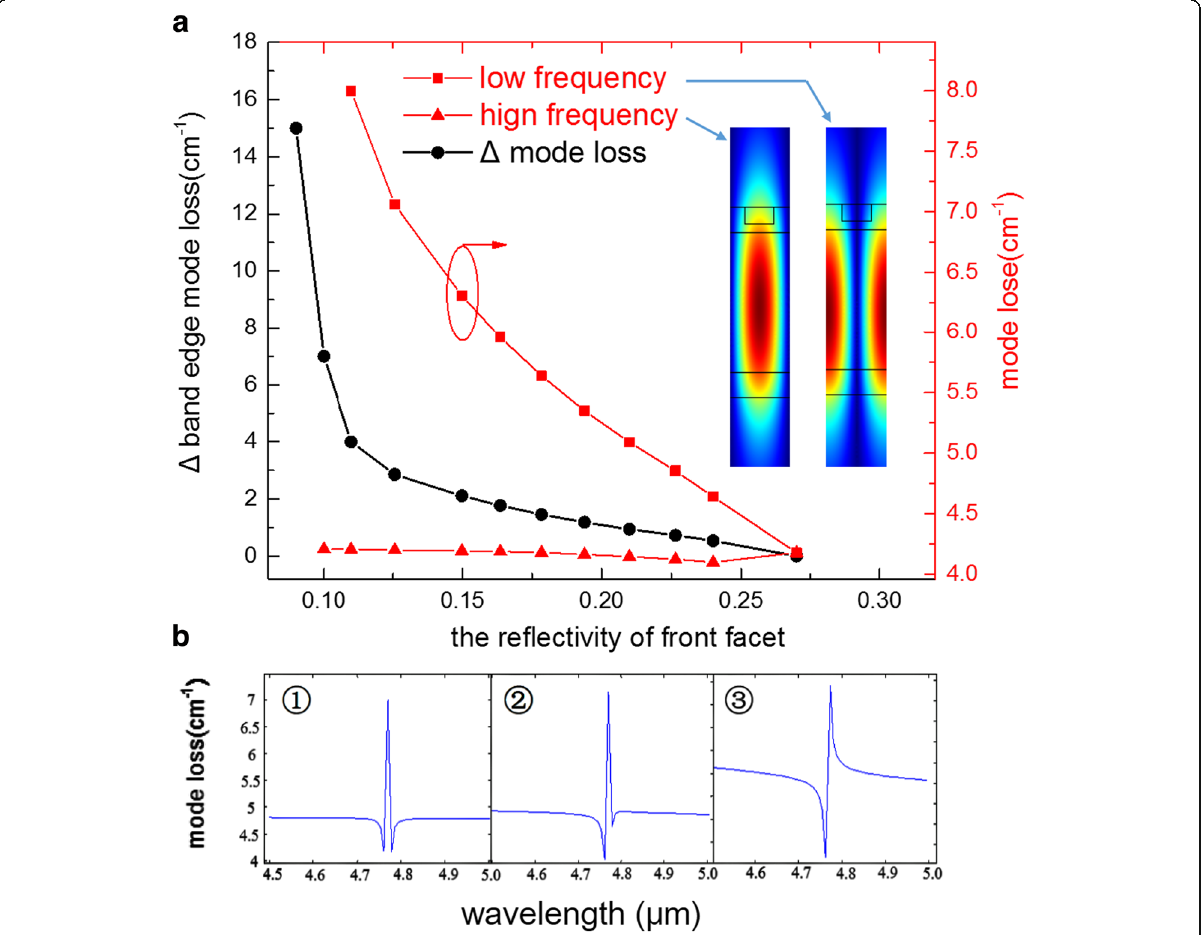
Fig. 2 a The two red curves are the mode loss of high- and low-frequency mode respectively. The black curve is the differential mode loss between the two band-edge modes labeled as Δ . The inset shows the mode profile calculated for the low- and high-frequency modes, for a single period of the grating. b The calculated mode loss spectrum based on transfer matrix simulation with different AR